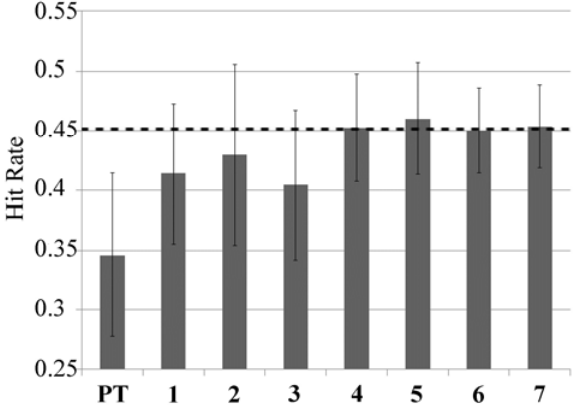
Figure 3 – The average hit rate increased following the pre- testing session (PT) through the first 3 testing sessions, then did not change between sessions 4 to